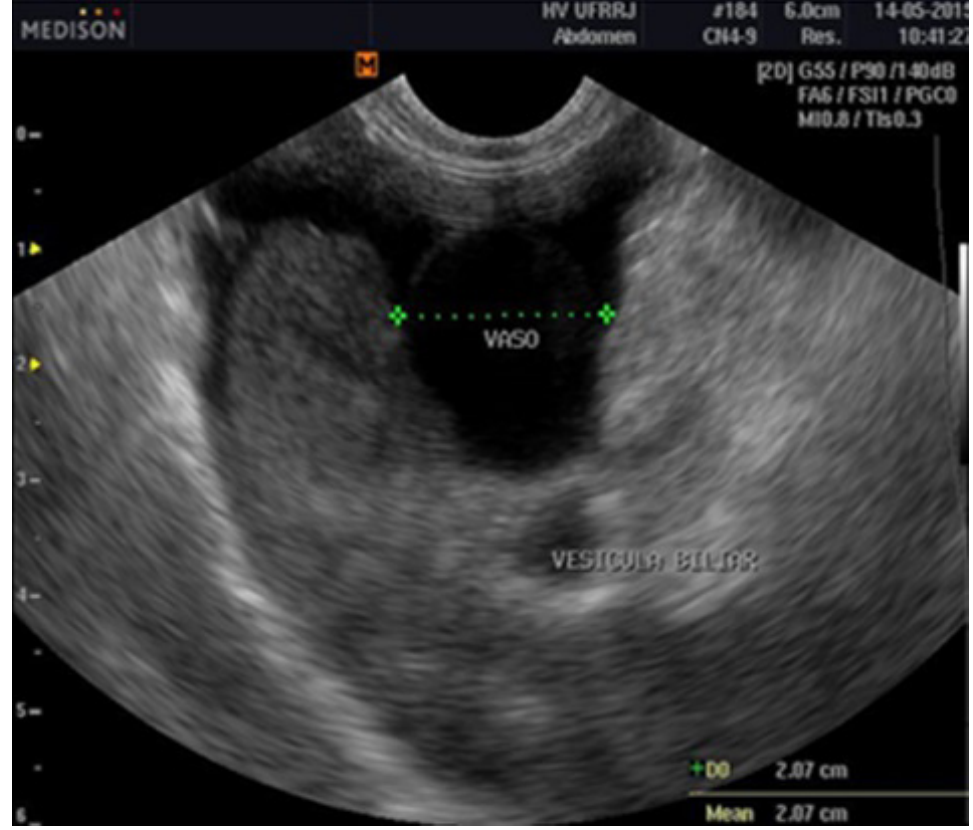
Figura 1. Imagem ultrassonográfica do fígado em modo B. Nota-se grande distensão